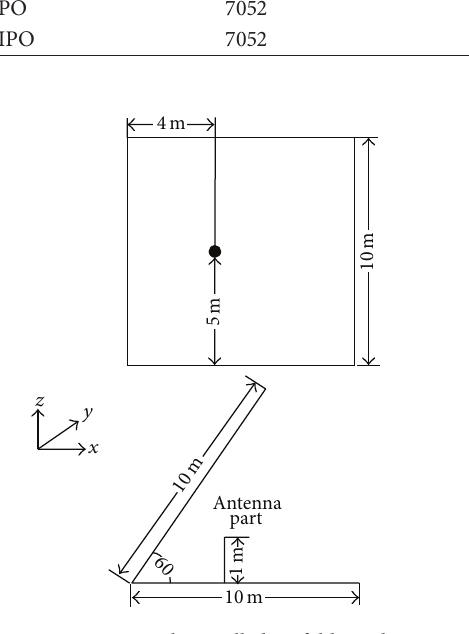
Figure 7: A monopole installed on folding planes.